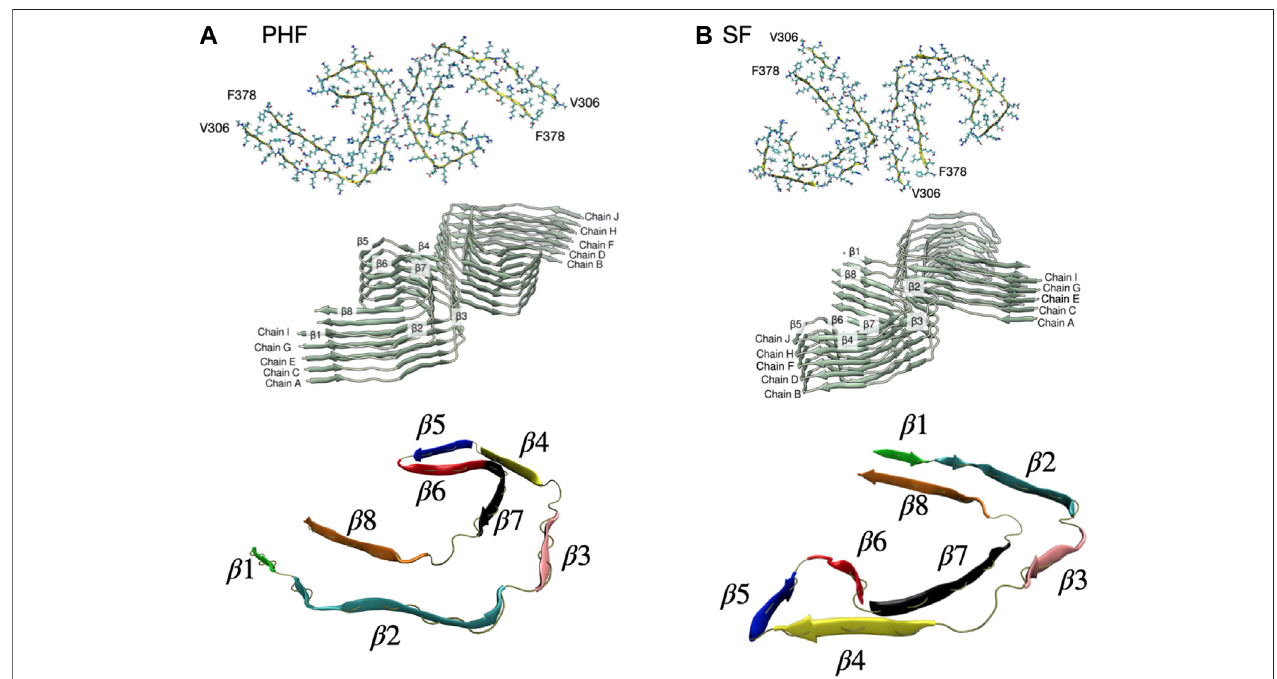
FIGURE 1 | (A) PHF proto fi lament based on the cryo-EM R3-R4 structure of residues V306-F378 (PDB ID entry 503 L). We used ten total chains labelled A-J arrangedas fi vepaired fi laments.TheC-shapedcorestructurehaseight β sheetslabelled β 1- β 8. (B) SFproto fi lamentbasedonthecryo-EMR3-R4structureofresidues V306-F378 (PDB ID entry 5O3T). The SF structure has the same eight β sheets labelled β 1- β 8 but a different orientation of paired fi laments. A rendered view of the secondary structure is shown at the bottom with the β sheets individually